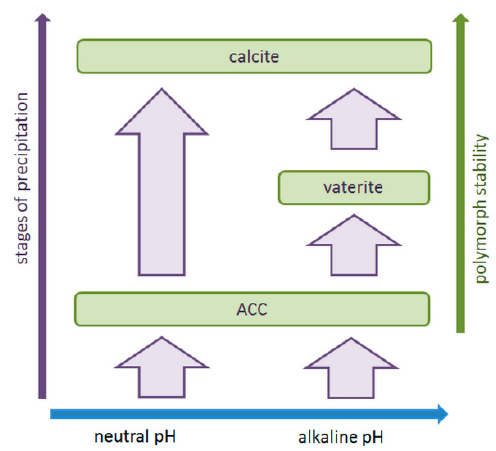
Figure 4. The diagram of CaCO 3 precipitation stages for a neutral and alkaline pH (according mechanisms proposed by Rodriguez-Blanco et al.